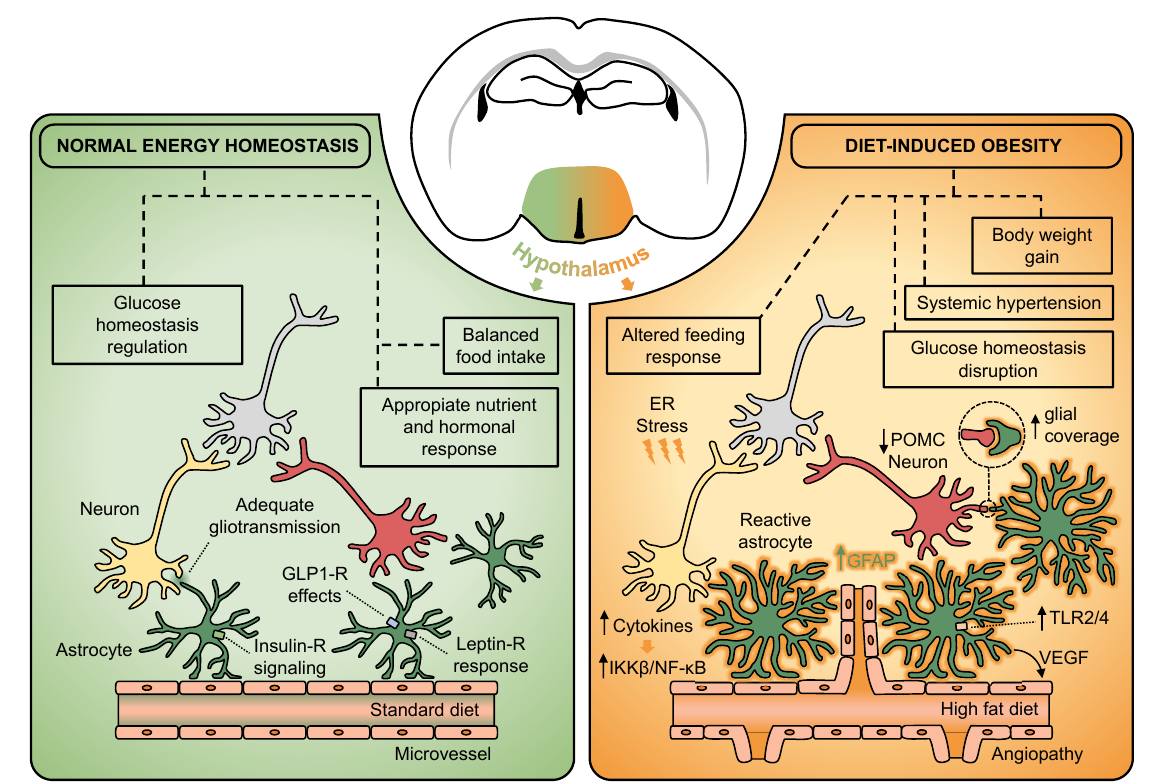
Figure 1. Hypothalamic astrocytes participate in the regulation of metabolic homeostasis and act as key players in the development of diet-induced obesity. Astrocytes located in the hypothalamus express several endocrine receptors such as, insulin, leptin, and GLP-1. The action of hormones and pharmacological analogues on hypothalamic astrocytes has been described to influence several aspects of normal energy homeostasis. Under energy-dense diet exposure, the hypothalamus experiences a low-grade inflammation characterized by a rapid rise in cytokines, which trigger downstream pathways such as the IKK β /NF- κ B and TLR2/4. This also leads to increased hypothalamic ER stress, which seems to interfere with the adequate response to hormones. Together, there is an HFD-reactive astrogliosis characterized by an overexpression of GFAP, the acquisition of a hypertrophic morphology, and a synaptic input reorganization of the melanocortin system, which may suggest a direct involvement of hypothalamic astrocytes in the pathogenesis of diet-induced obesity. At vascular level, obesogenic diets trigger astroglial VEGF-driving angiogenesis in the hypothalamus to promote the development of systemic hypertension. ER, endoplasmic reticulum; IKK β , IkB kinase- β ; GFAP, glial fibrillary acidic protein; GLP-1, glucagon-like peptide-1; NF- κ B, nuclear factor κ B; POMC, proopiomelanocortin; TLR2/4, toll-like receptor 2/4; VEGF, vascular endothelial growth